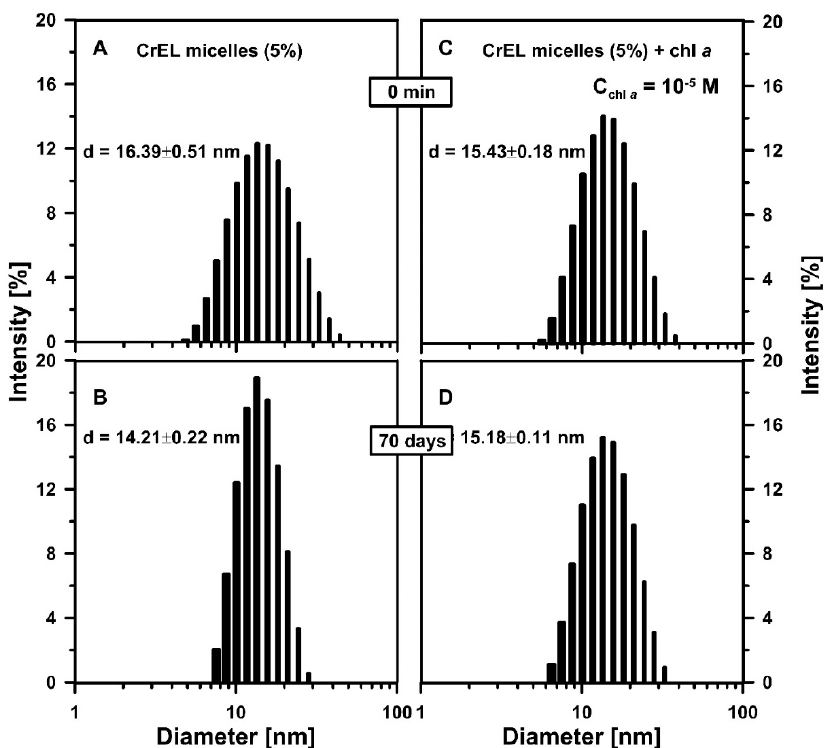
Figure 1. Cremophor micelles size distribution histograms. ( A , B ): the PBS buffer containing 5 wt% Cremophor EL (CrEL) (CrEL micelles (5%), 5 wt% Cremophor nano-emulsion). ( C , D ): An amount of 5 wt% Cremophor nano-emulsion mixed with chlorophyll a (chl a ) at the molar concentration of 10 − 5 M (CrEL micelles (5%) + chl a ). ( A , C ) The histograms were measured directly after the sample preparation (0 min). ( B , D ) The samples were stored for 70 days in the dark conditions. Histograms were obtained using the dynamic light scattering method. The representative sizes of nano-micelles are included in the figure (obtained from the presented histograms, numbers represent the mean values obtained by replicate measurements of the same sample, n = 3 technical replicates). The experiment was repeated three times (biological replicates).